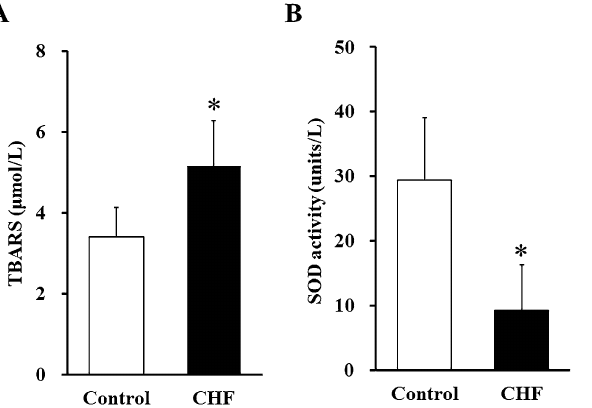
Figure 1. Systemic oxidative stress. ( A ) Serum TBARS (lipid peroxides) and ( B ) serum SOD activity (an antioxidant defense capacity). White bars: Control subjects (n = 13). Black bars: CHF patients (n = 17). Data are